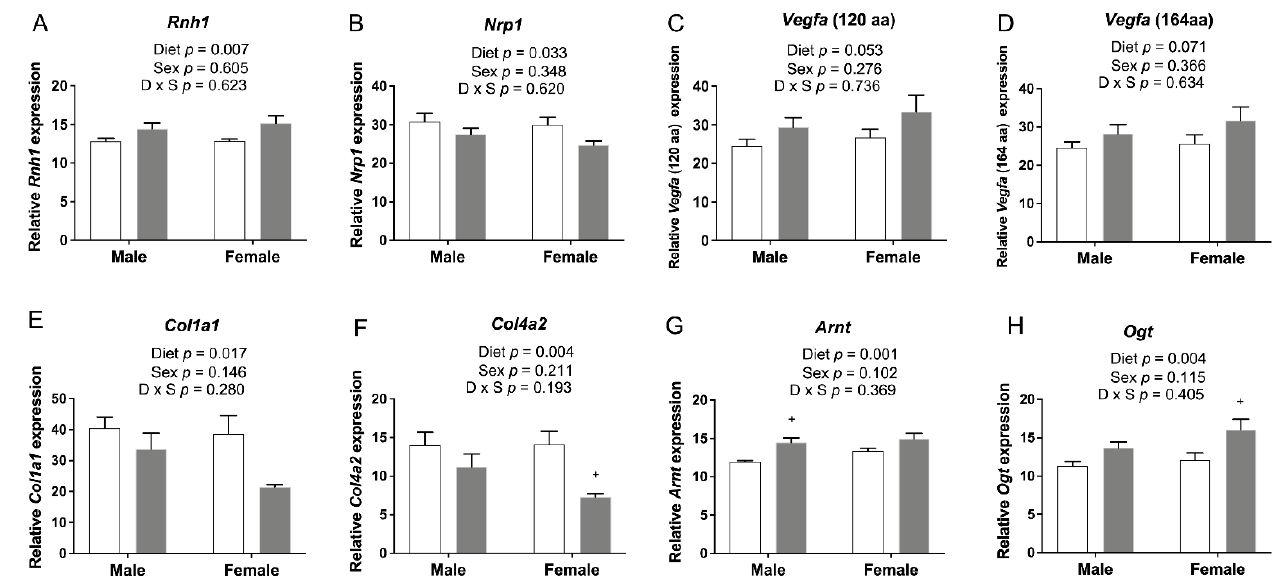
Figure 7. qRT-PCR of candidate genes involved in angiogenesis in embryonic cerebrum. ( A ) mRNA levels of Rnh1 were significantly increased by FASD. ( B ) mRNA levels of Nrp1 were significantly decreased in the FASD group. mRNA levels of two Vegfa isoforms, ( C ) Vegfa 120 and ( D ) Vegfa 164, showed a trend toward a significant increase by FASD. mRNA levels of ( E ) Col1a1 and ( F ) Col4a2 were significantly decreased in the FASD group. mRNA levels of ( G ) Arnt and ( H ) Ogt were significantly increased in the FASD group. Values are means ± SEM of 5–6 per group. White bars: CD groups; gray bars: FASD groups. p -Values from 2-factor ANOVA are indicated in each graph. Tukey post hoc p -values are indicated as + p < 0.05. CD, control diet; FASD, folic-acid-supplemented diet; D: diet; S: sex; D × S: diet × sex